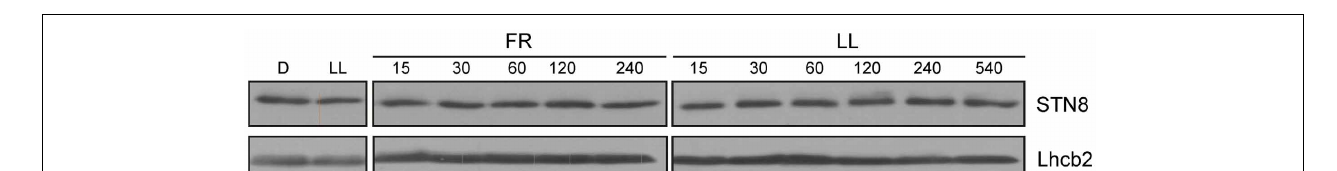
eluates from rec (cid:2) TRX-f and -m resins were subjected to Western blot analysis using STN7-specific antibodies. Solubilized WT (Col-0) thylakoids (input; corresponding to 10 μ g of Chl), the flow through off the rec (cid:2) TRX-f resin (flow; equivalent to 10 μ g Chl), washes 1–3 of the rec (cid:2) TRX-f resin and the eluate from a similarly treated Ni-NTA resin not coupled to rec (cid:2) TRX (mock elution) were loaded as controls. (C) TRX-f mobility shift assay. Thylakoid membranes (10 μ g Chl) from WT (Col-0), STN7 C −→ S : 65 + 70 and stn7-1 mutants were solubilized with 0.2% DOC and incubated with either 25 μ g of rec (cid:2) TRX-f or without additives. Proteins were separated by non-reducing SDS-PAGE and Western analysis was performed using STN7-specific antibodies.